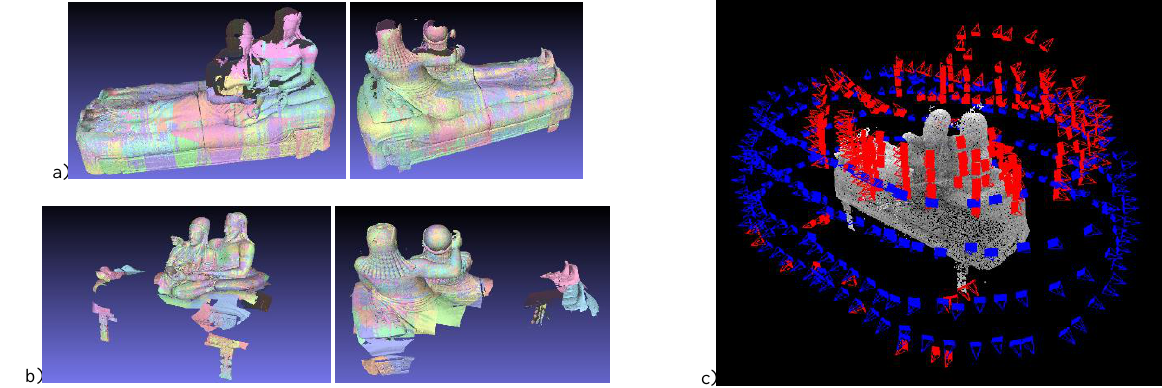
Figure 4. Laser scans acquired with the wide (a) and medium lenses (b). Photogrammetric camera network (c): images acquired for the main block are displayed in blue, images acquired for the most difficult parts (spouses’ trunks, hands, feet) are in